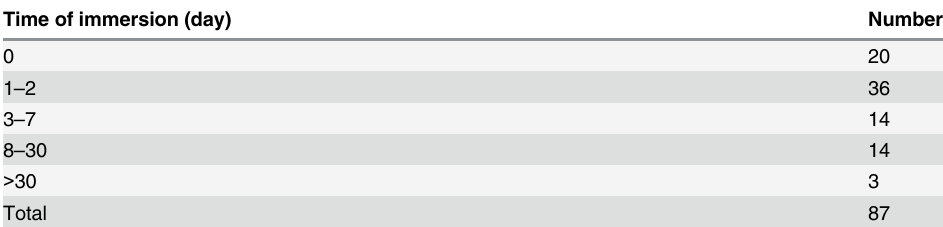
Table 5. Time of immersion.